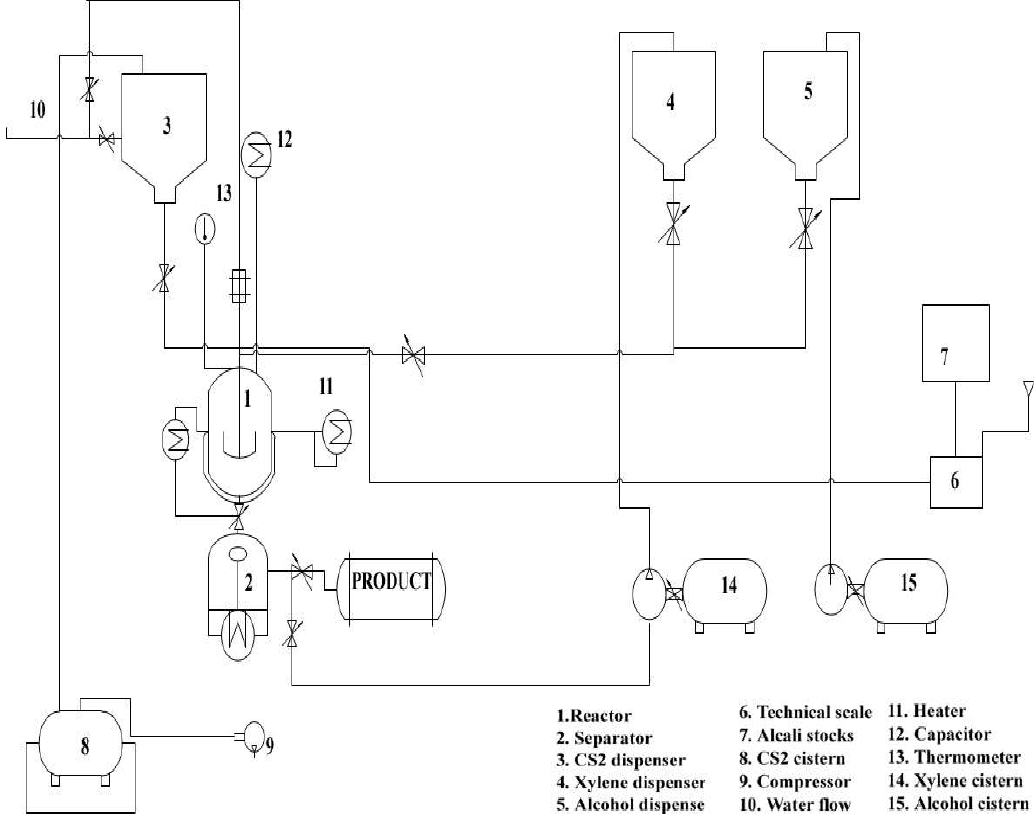
Figure 7. Schematic overview of the technological process for the production of liquid alkyl xanthate. In the 5 m 3 reactor (1), 60.0 kg (1.1 kmol) of 98% potassium hydroxide and 130 L of water